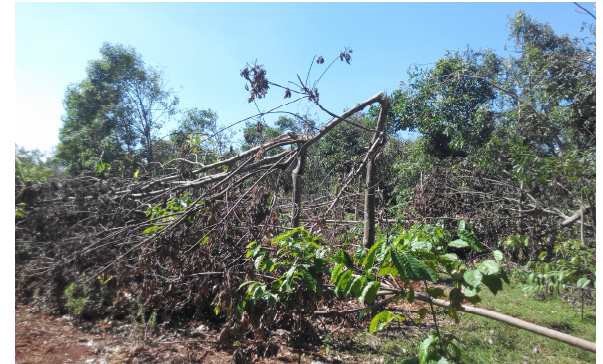
Figure 2. Broken rubber trees after Typhoon Rammasun (201409)